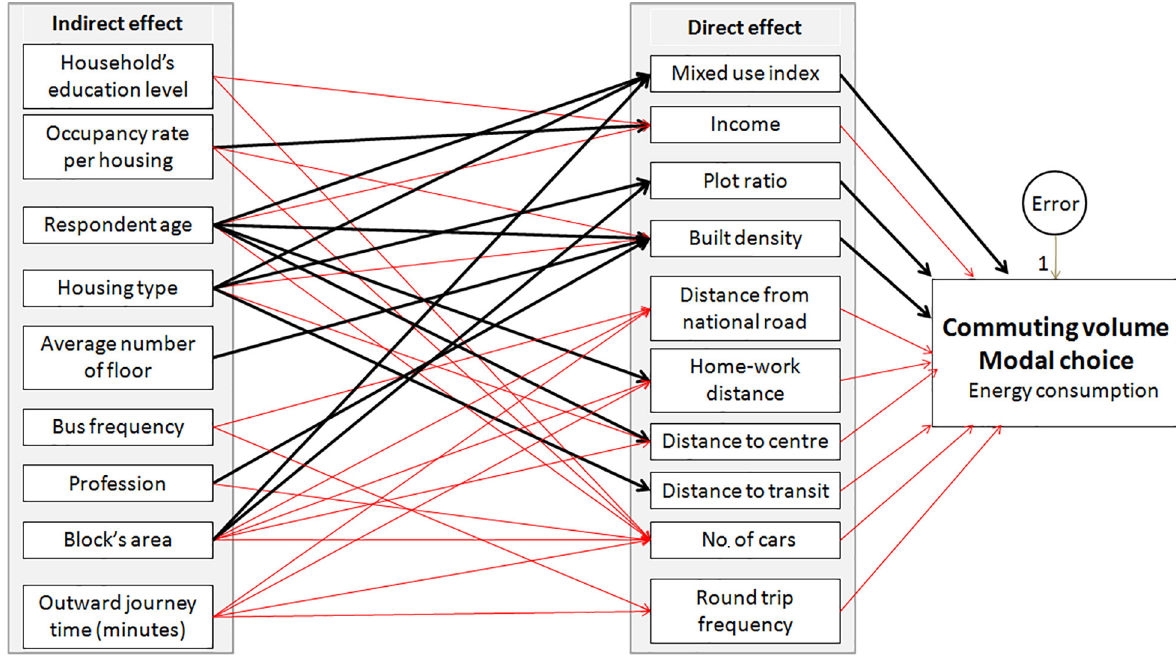
Fig. 3. The hypothesised